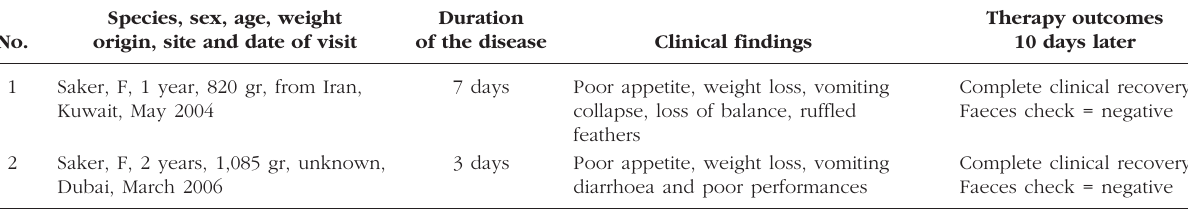
Table I. – Signalment, clinical findings and results of therapy with ivermectin (Ivomec ® , Merial, 2 mg/kg, im.) in two falcons diagnosed with Acanthocephalan worms.